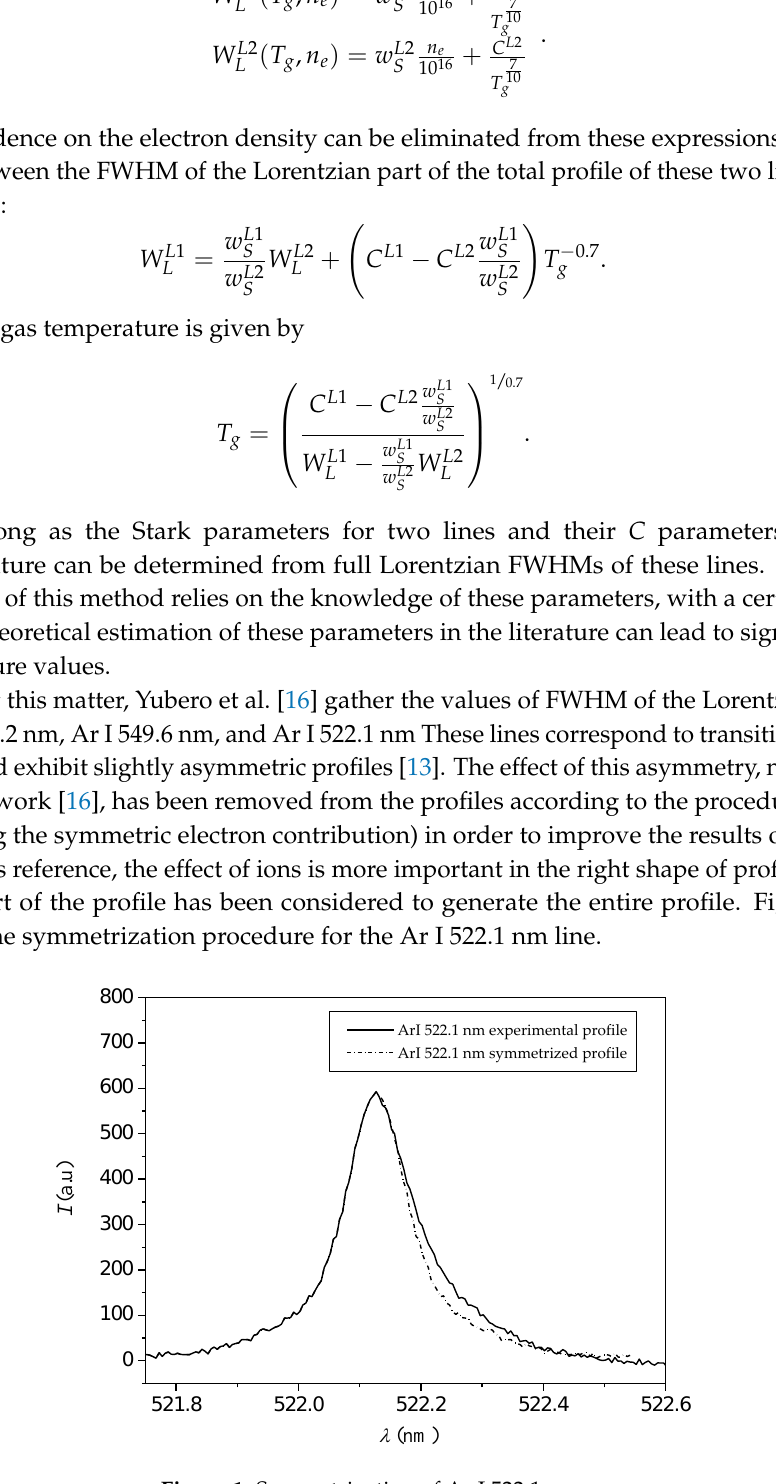
Figure 1. Symmetrization of Ar I 522.1 nm. Table 1. C coefficients calculated from Equation (8), and the Stark broadening parameters due to electron impacts theoretically determined by Dimitrijevi ć et al. [22] for an electron temperature of 10,000 K and an electron density of 10 16 cm −3 .